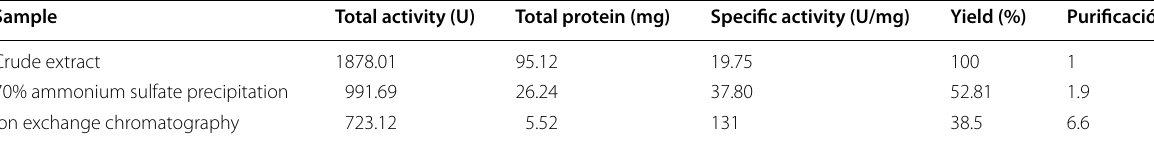
Table 2 Purification steps of xylanase Lr XynA from L. ramosa H71D Sample